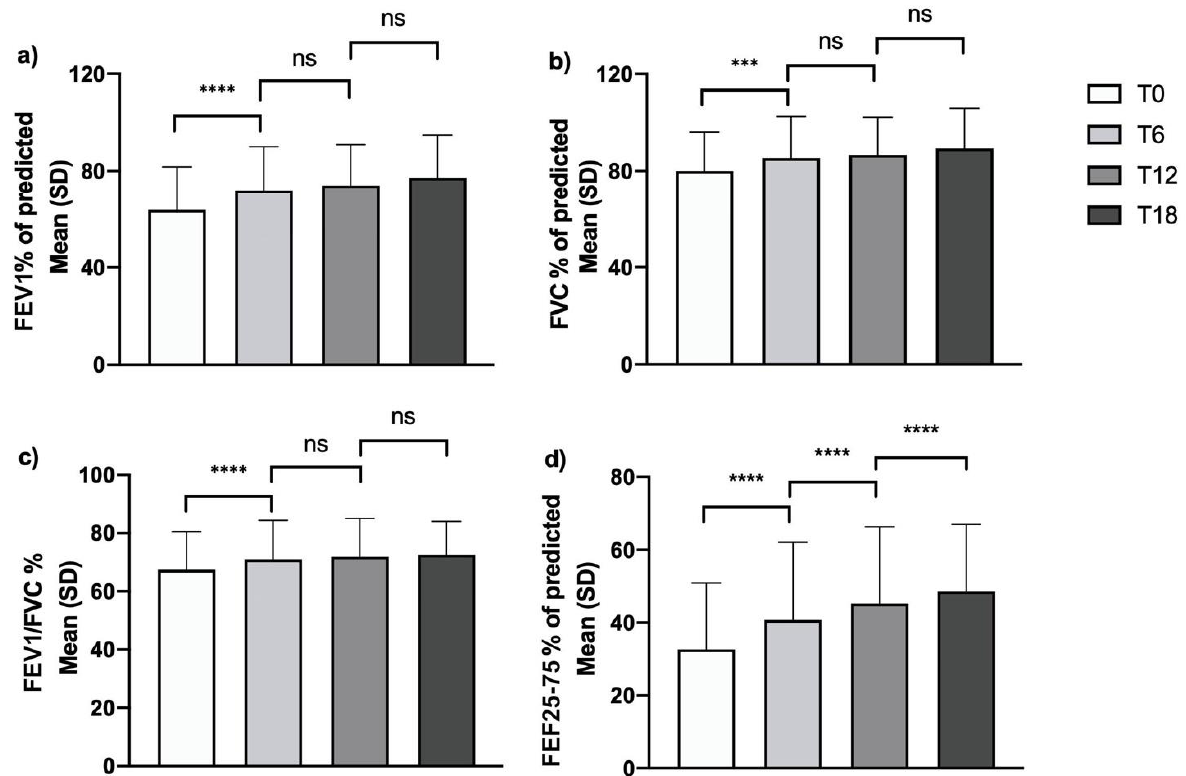
Figure 4. Effects of mepolizumab on pulmonary function tests: changes over time in ( a ) FEV1% of predicted; ( b ) FVC% of predicted; ( c ) FEV1/FVC%; ( d ) FEF25-75% of predicted (***: p = 0.001; ****: p < 0.0001; ns, non-significant).